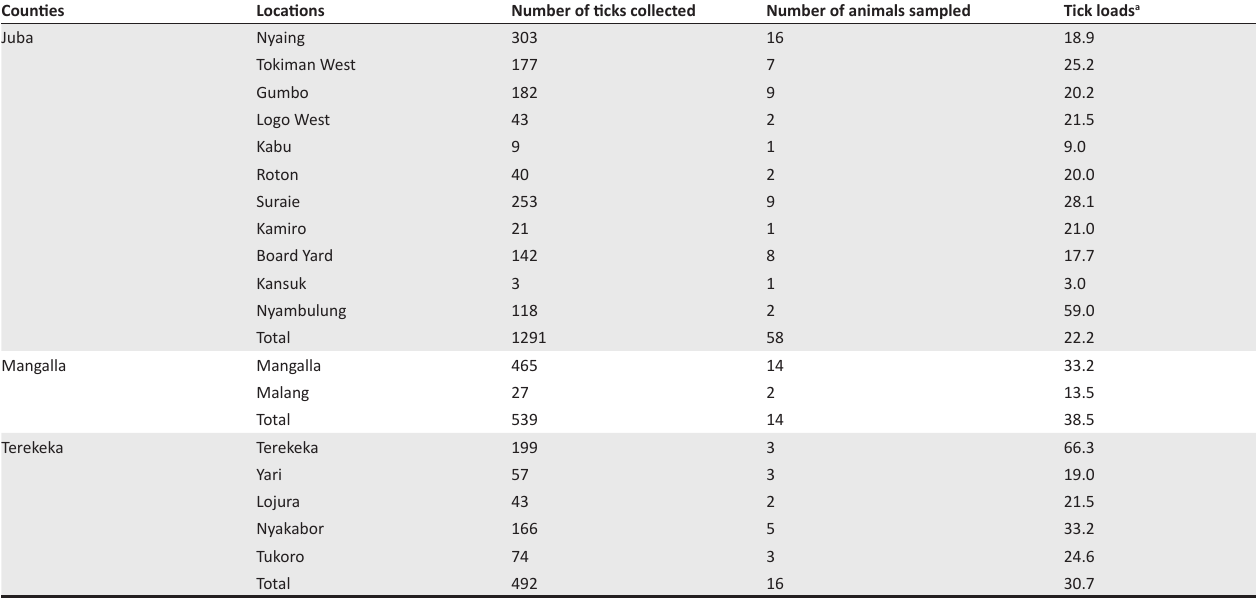
TABLE 2: Tick loads at selected locations in the Central Equatoria region, Sudan (December 2004; January–June 2005).